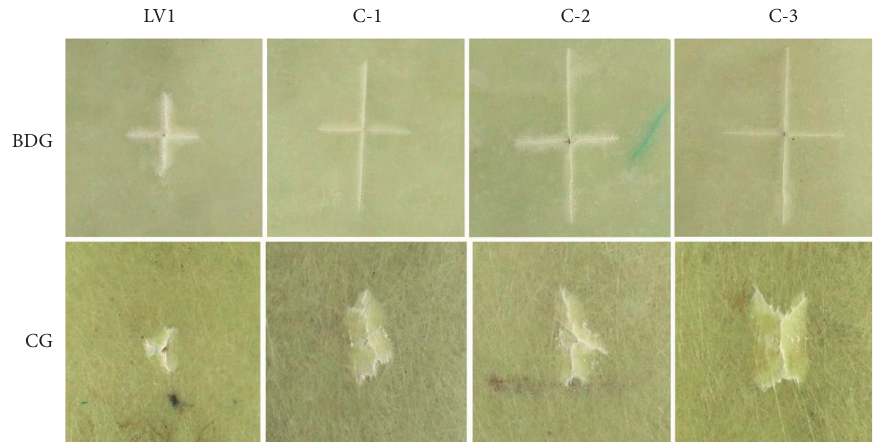
Figure 7: Damage pattern of bidirectional and chopped laminates subjected to low-velocity impact (LVI) and cyclic